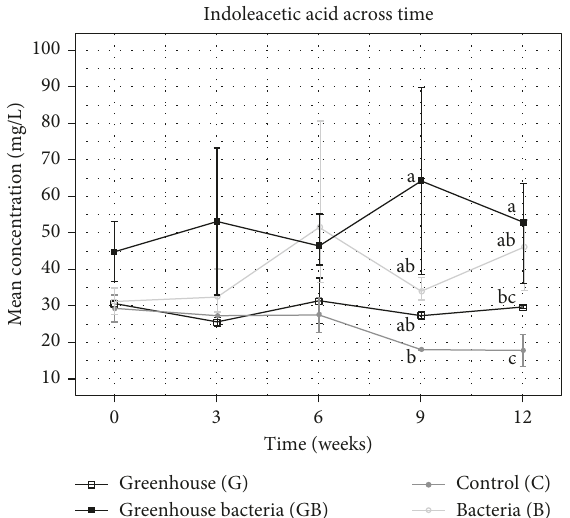
Figure 6: Indole acetic acid per treatment across time. Means within a time measured followed by the same letter are not sig- nificantly different according to the Tukey–Kramer test or Nemenyi test in case of no normality.